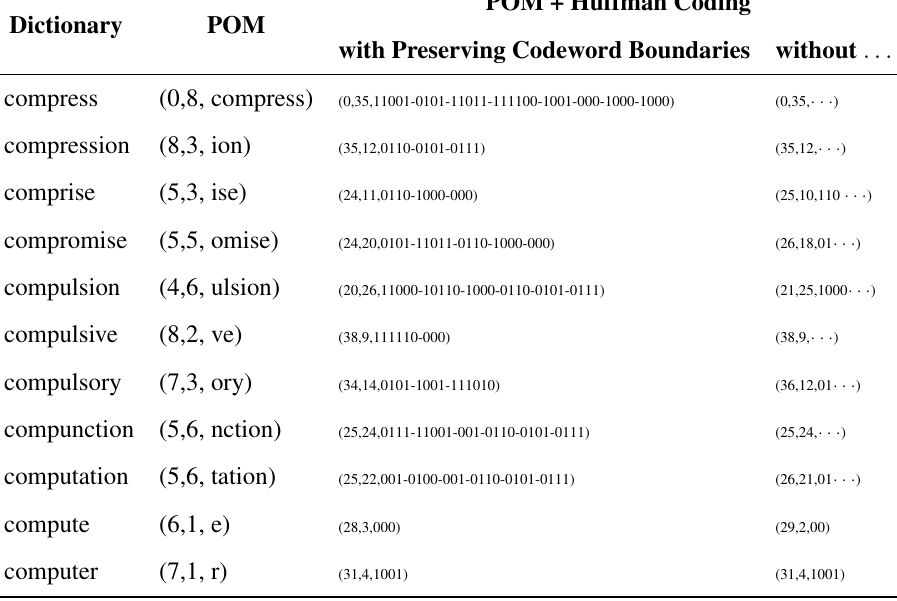
Table 1. Example POM and the combined POM +